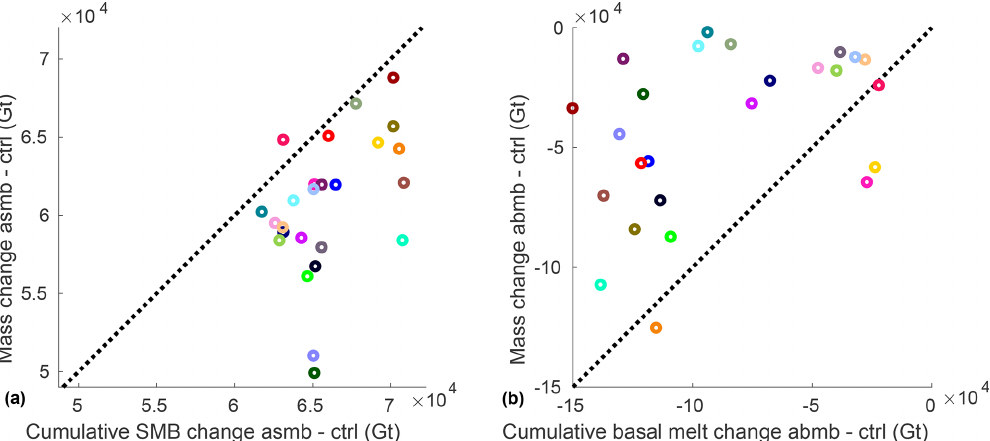
Figure 9. (a) Difference in mass (Gt) between the end of the asmb experiment and the end of the ctrl experiment and the cumulative SMB anomaly (Gt) of the asmb experiment integrated over the entire ice sheet for the 25 simulations. (b) Difference in mass (Gt) between the end of the abmb experiment and the end of the ctrl experiment and the cumulative basal melt anomaly (Gt) of the abmb experiment integrated over the entire ice sheet for the 25 simulations. Black dashed lines show mass change equal to cumulative anomaly